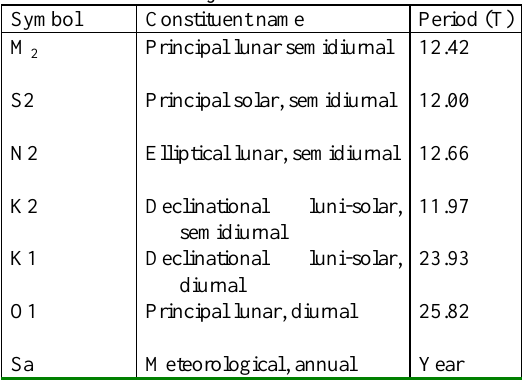
. Table 1. Major Harmonic